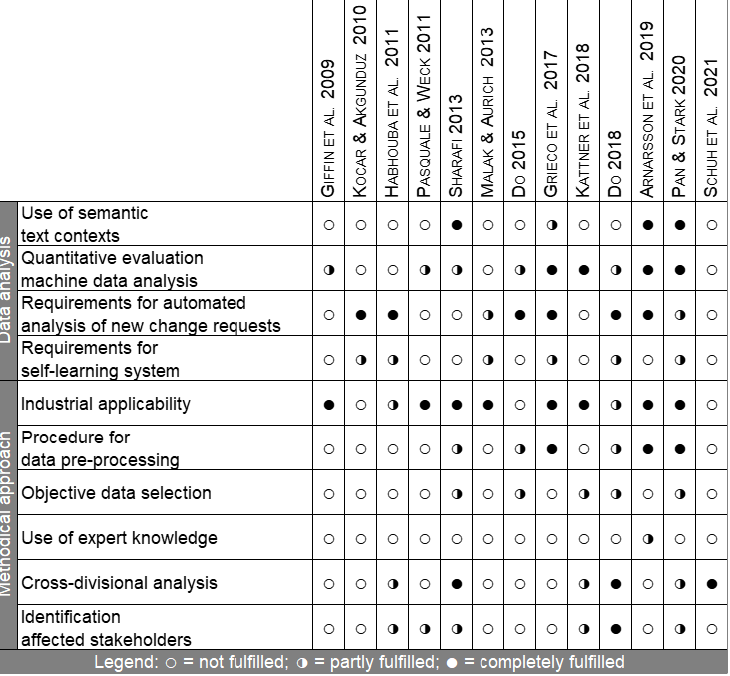
Figure A2. Categorization of relevant preliminary work